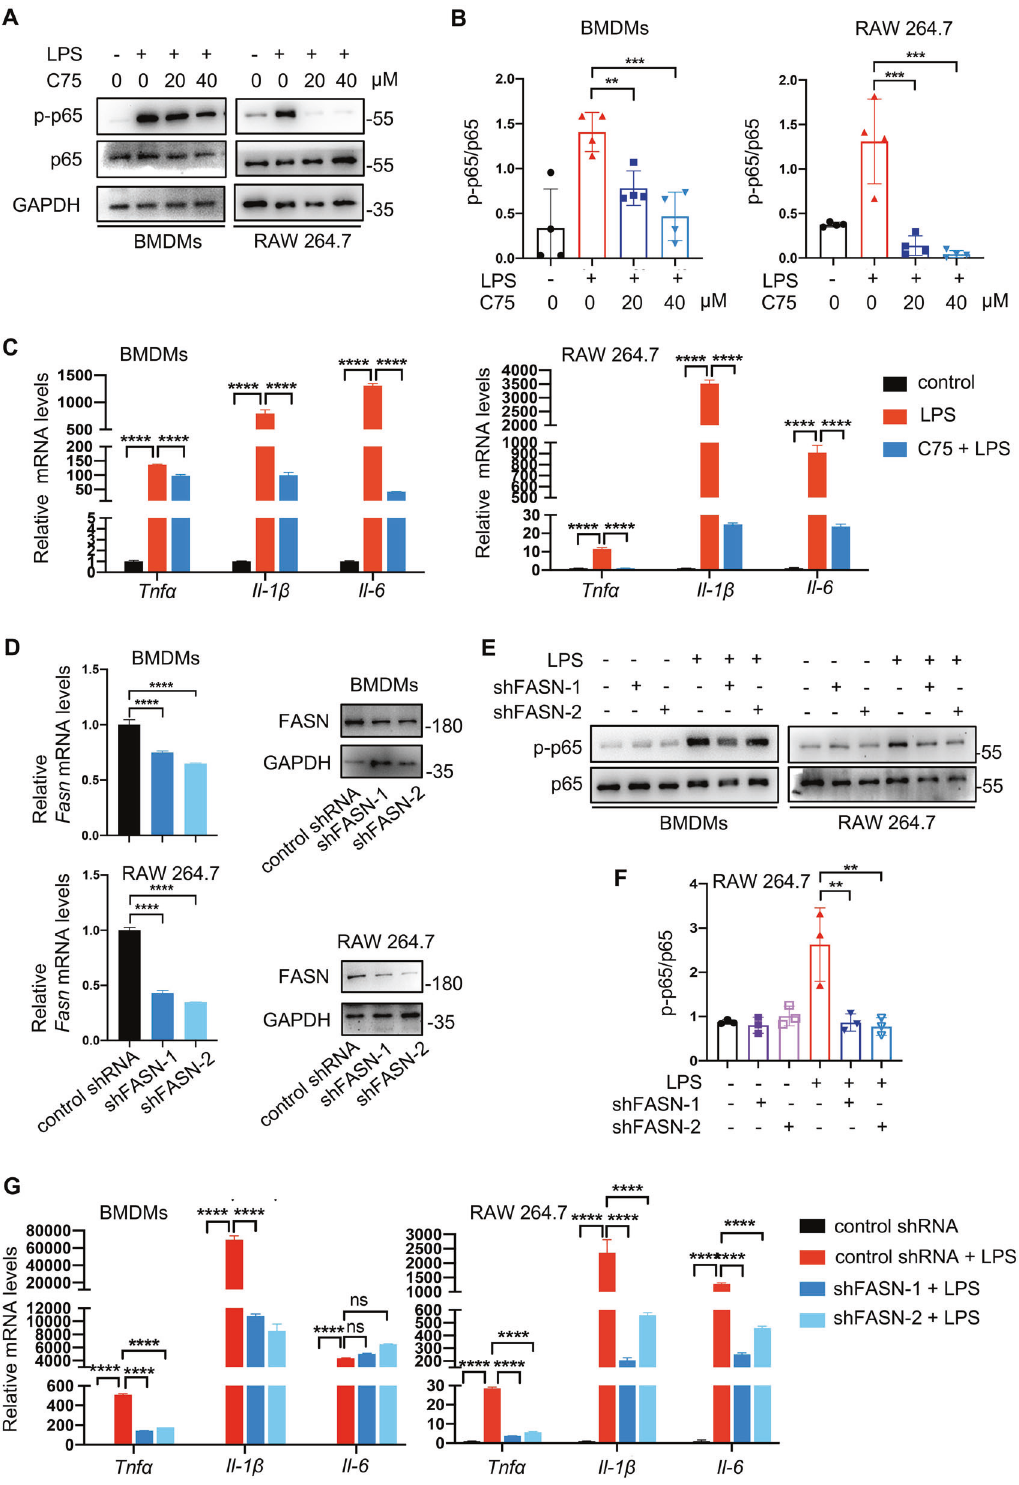
Fig. 2 The inhibition of fatty acid synthesis suppressed proin fl ammation responses of macrophages. A , B Treatment with various concentrations of C75 (FASN inhibitor) inhibited the phosphorylation of p65 in macrophages exposed to 100 ng/ml LPS for 30 min, as determined by Western blotting. Representative images of western blotting ( A ) and quanti fi cation of p-p65/p65 ratios ( B ). C The relative mRNA levels of Tnf α , Il-1 β , and Il-6 were detected by qRT-PCR after treatment with 100 ng/ml LPS in the presence or absence of 20 μ M C75 for 4 h ( n = 3). D Macrophages were transduced with Fasn shRNA or control shRNA lentivirus constructs. The ef fi ciency of knockdown was con fi rmed by qRT-PCR ( n = 3, left) and Western blotting (right). E , F Knockdown of Fasn suppressed p65 phosphorylation in macrophages triggered by 100 ng/ml LPS for 30 min, as determined by Western blotting. Representative images of western blotting ( E ) and quanti fi cation of p-p65/p65 ratios ( F ). G Fasn -knockdown macrophages were treated with 100 ng/ml LPS for 4 h. The mRNA levels of Tnf α , Il-1 β , and Il-6 were analyzed by qRT-PCR ( n = 3). Data were represented as means ± SD. * p < 0.05, ** p < 0.01, *** p < 0.001, **** p < 0.0001,